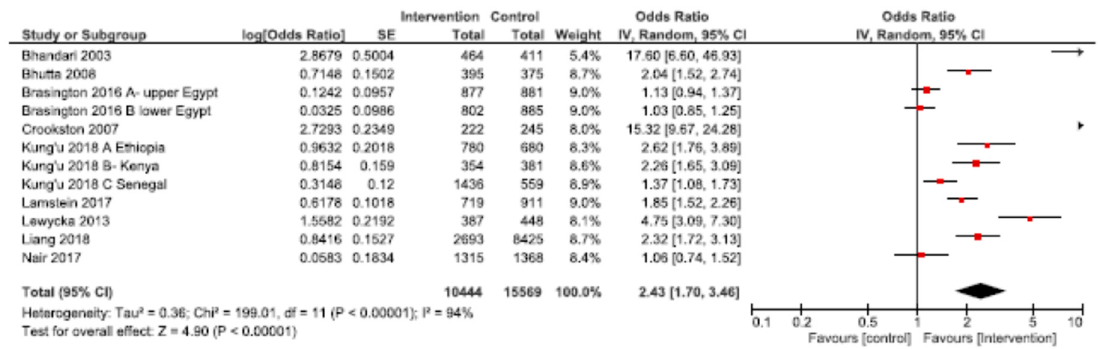
Figure 5. Forest plot of the meta-analysis of early initiation of breastfeeding for home visits and mother/peer groups.